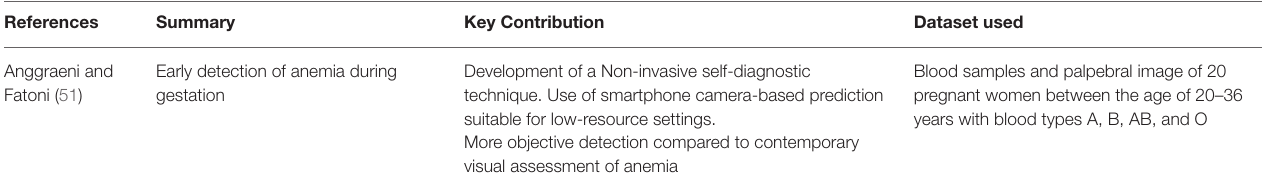
TABLE 6 | Summary of approaches used to predict gestational